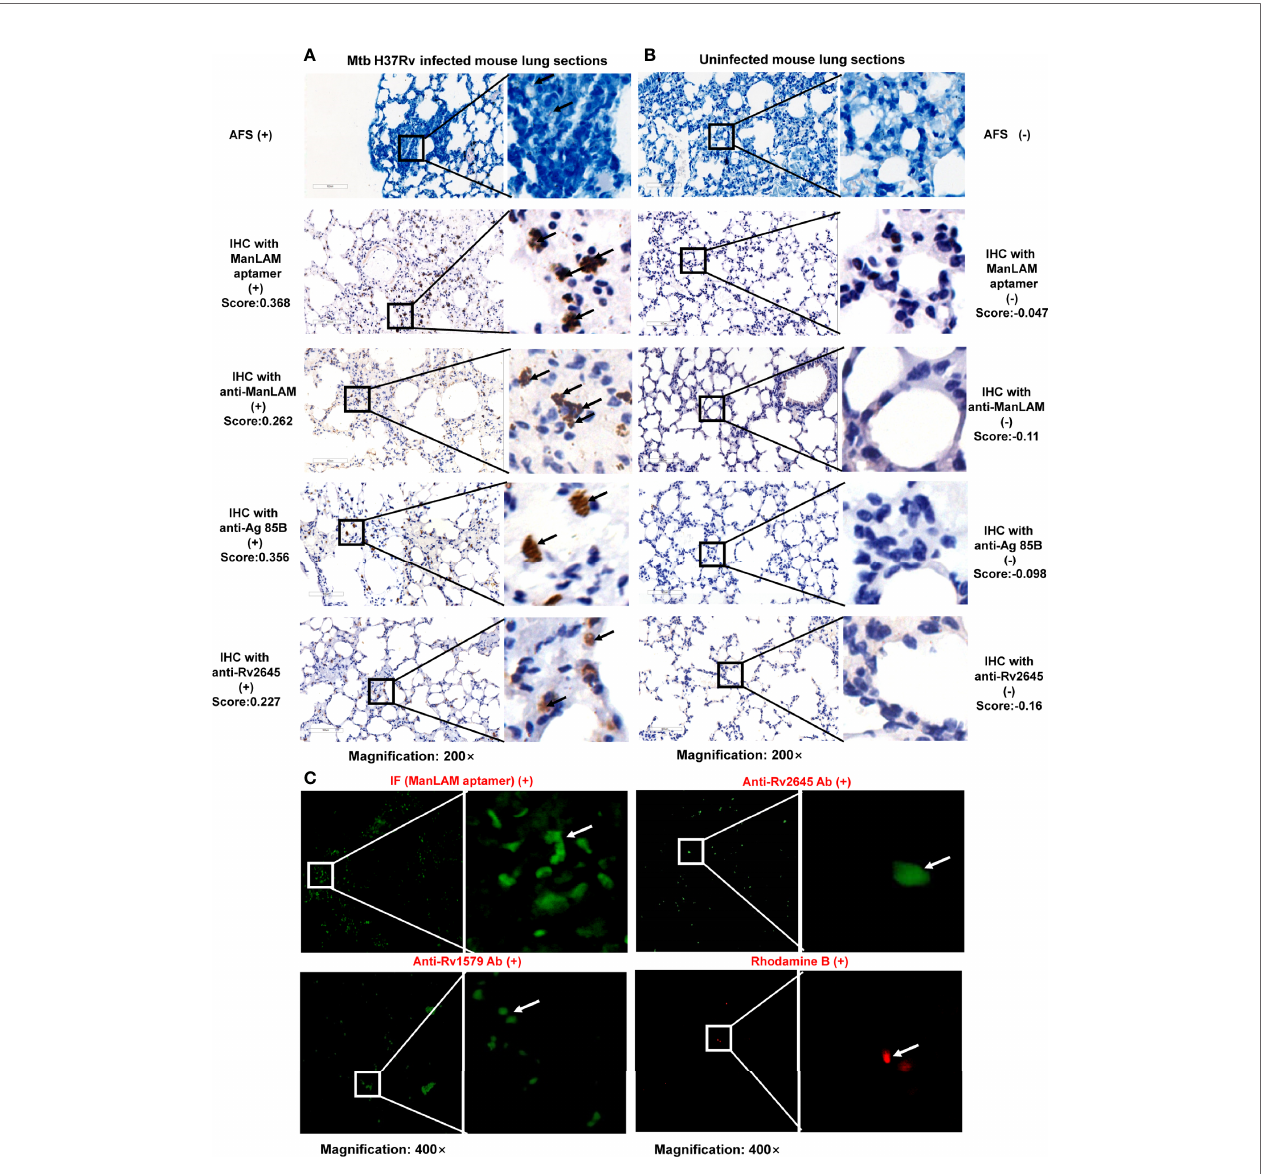
FIGURE 4 | Comparison of aptamer- and antibodies-based immunohistochemistry (IHC)/immuno fl uorescence for tuberculosis (TB) diagnosis in TB mouse model. Images of M.tb H37Rv infected mouse lung sections (A) and uninfected mouse lung sections (B) detected by acid-fast staining (AFS), aptamer-based IHC, anti- ManLAM, anti-Ag85B, or anti-Rv2645 pAbs. Arrows indicate positive signals (aptamer-based IHC by brown granular staining; AFS by red staining). (C) . Images of infected mouse lung sections detected by AF488 labeled ManLAM aptamer-based immuno fl uorescence, anti-Rv1579, anti-Rv2645 pAbs developed with AF488- anti-IgG and Rhodamine B (RB). RB is a kind of M.tb speci fi c fl uorescence dye, used as a positive control. Samples with a score less than the cutoff value (0.0580) were designated as “ - ” , ( ≥ 0.0580 and <0.5010) as “ + ” , ( ≥ 0.5010 and <0.8780) as “ ++ ” , >0.8780 as “ +++ ” . The numbers (0.5010 and 0.8780) were determined by calculating the 50% and 75% percentile of the